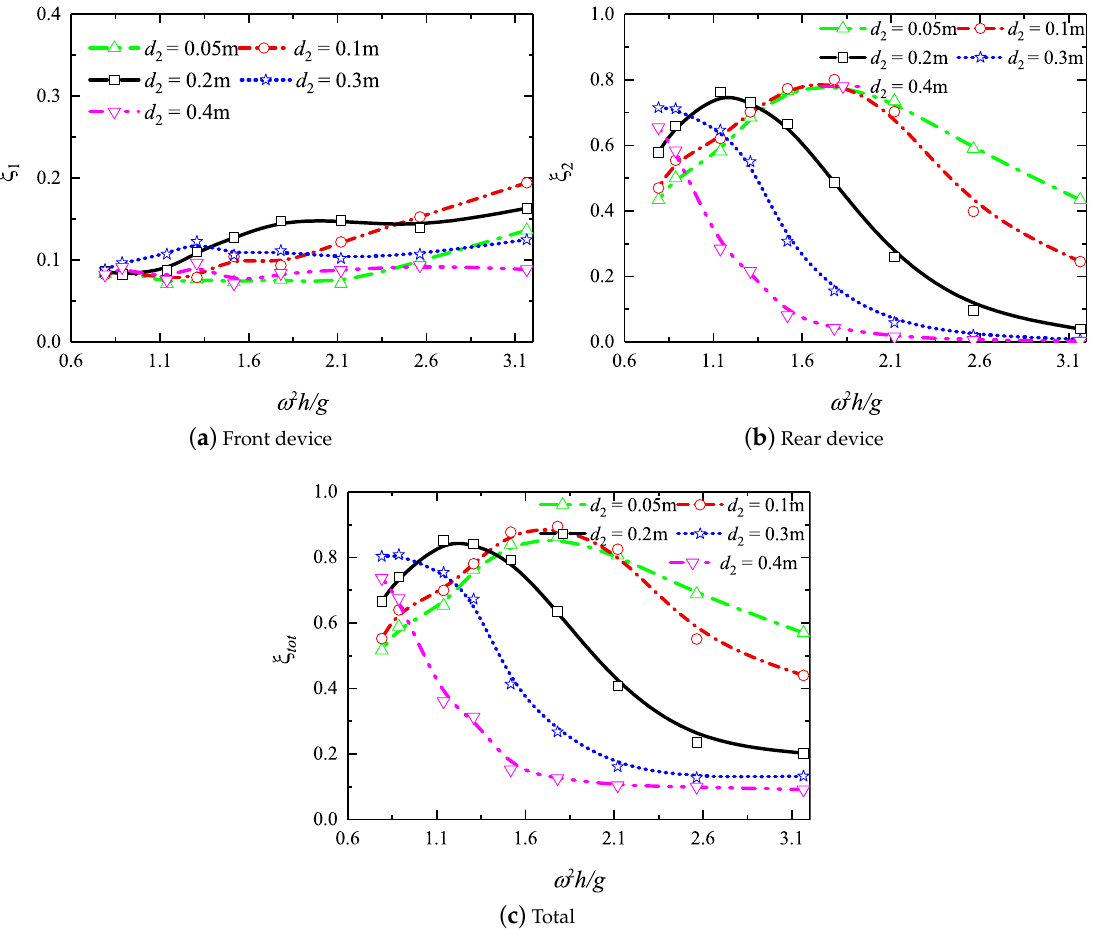
Figure 13. Effects of the back-lip draught d 2 on the extraction efficiencies of the front and rear devices and the total